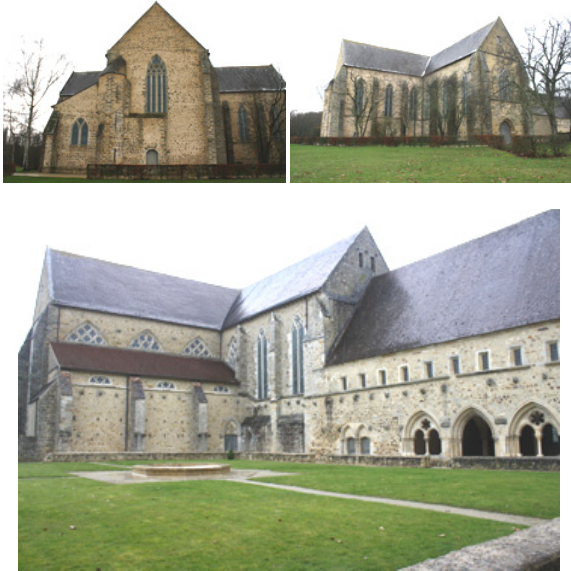
Figure 1. Abbey of Epau: Top: two views of the abbey-church. Bottom: cloister